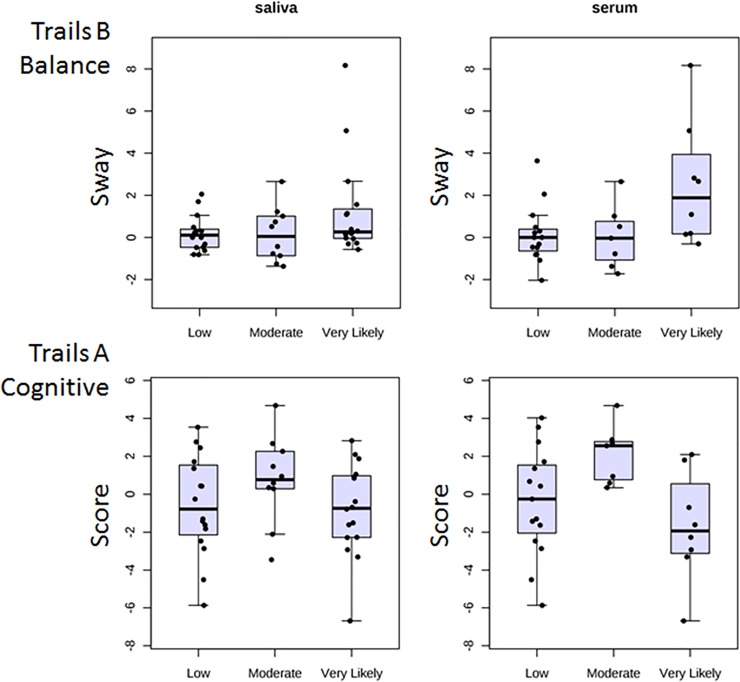
Changes in body sway or completion time scores post-fight are less consistent in two different dual-task functional tests.Subjects are grouped by TBI likelihood. Same conventions as Fig 2. Note slightly elevated scores in the Very Likely group of the TMB_Bal task (upper) when a serum (but not a saliva) sample was taken, and the slight elevation in the TMA_Cog score (lower) in the Moderate (but not Very Likely) group.